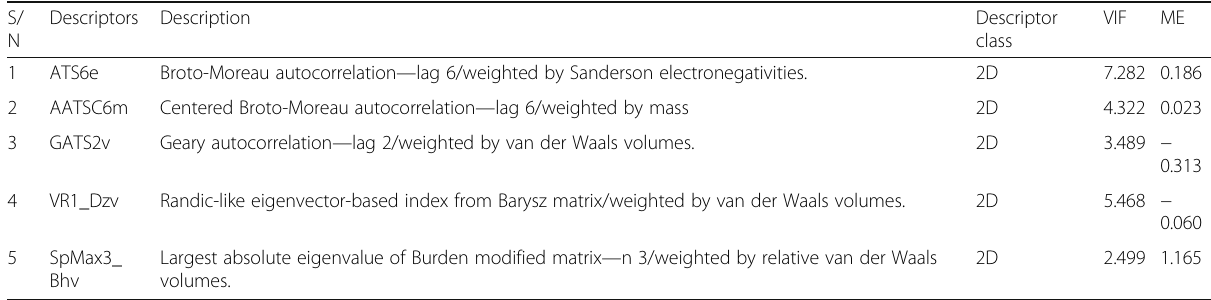
Table 9 List of descriptors and their respective classes and statistical parameters S/